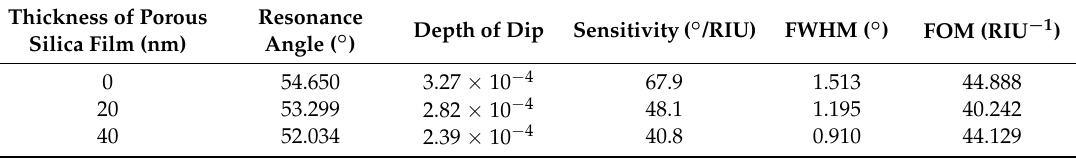
Figure 6. The angular spectra of the SPR sensors with 0 (traditional SPR sensor), 20, and 40 nm thick 60% porosity porous silica film ( n ps = 1.176). Table 3. The performance parameters of the SPR sensors with 0 (traditional SPR sensor), 20, and 40 nm thick 60% porosity porous silica film ( n ps = 1.176).